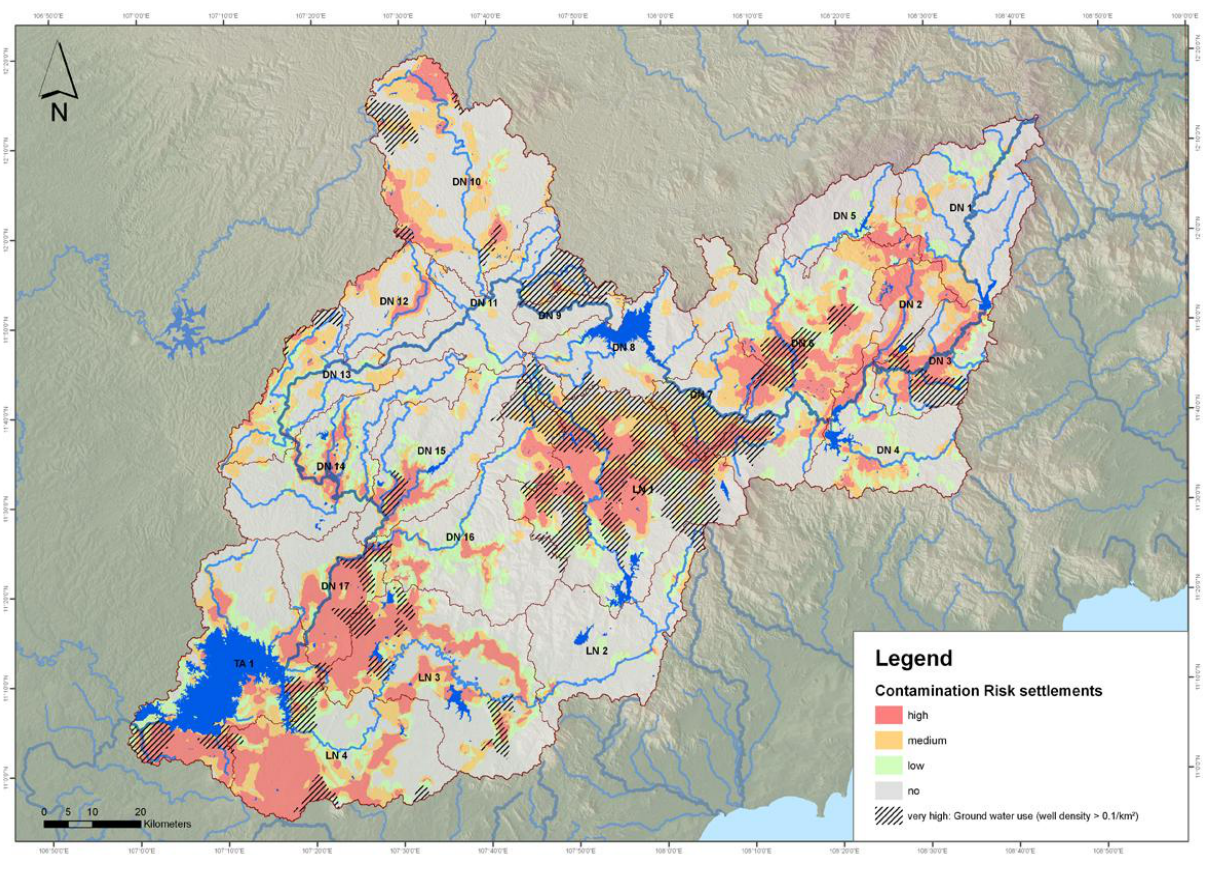
Figure 13. Map of contamination risk settlements (path